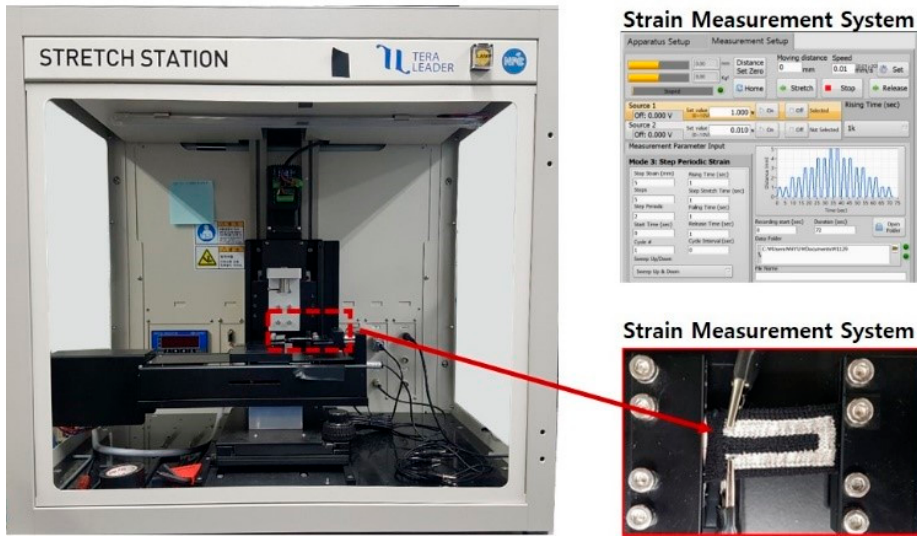
Figure 3. A universal strain testing machine for the knitted strain sensor.